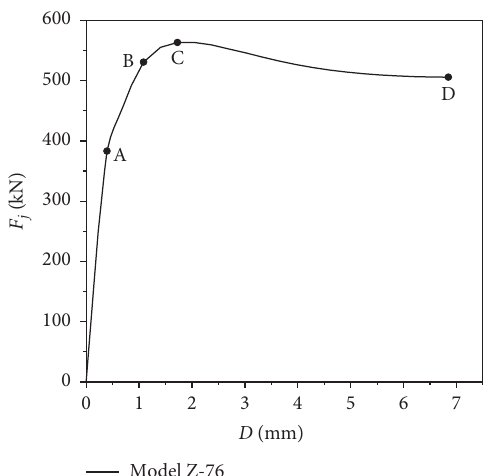
Figure 6: F − D (displacement) curve of model j